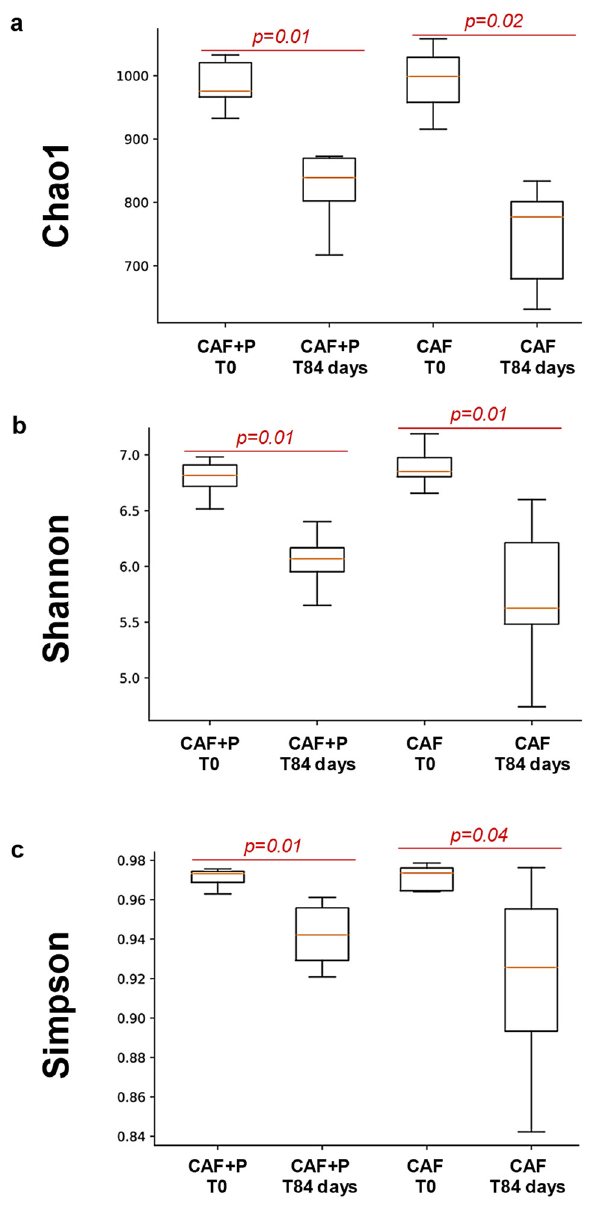
Figure 4. Comparison of alpha-diversity indices ( a ) Chao1, ( b ) Shannon and ( c ) Simpson in fecal samples collected at T0 and T84, within both CAF and CAF+P groups. Data are shown as means ± SD of 6–8 rats per group. p < 0.05 means significant differences in diversity indices (T84 vs. T0). CAF: cafeteria; P: probiotic supplementation.